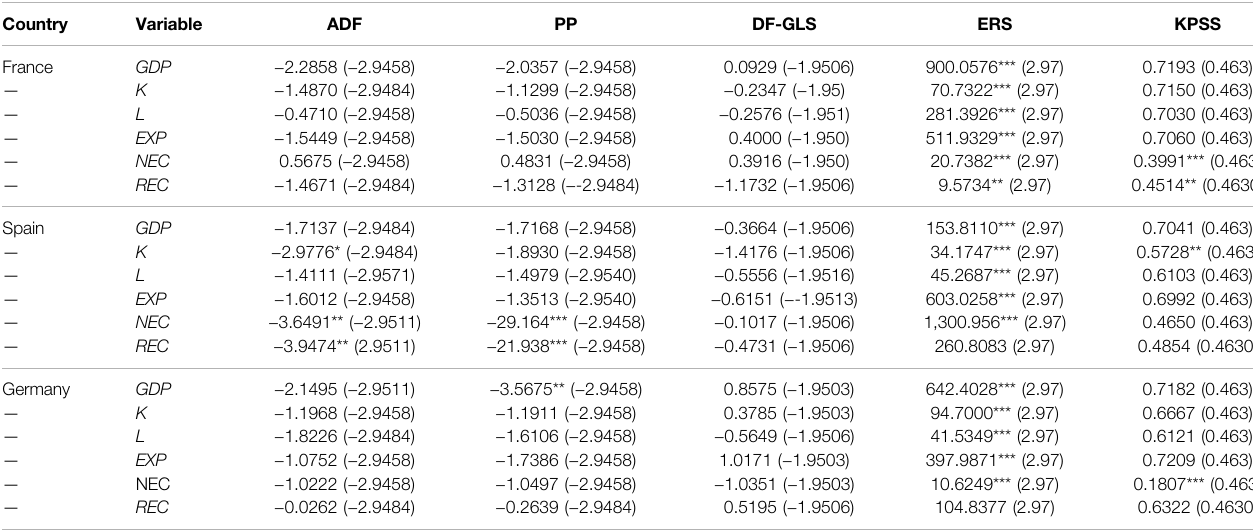
TABLE 5 | Results of the unit root tests for log-level